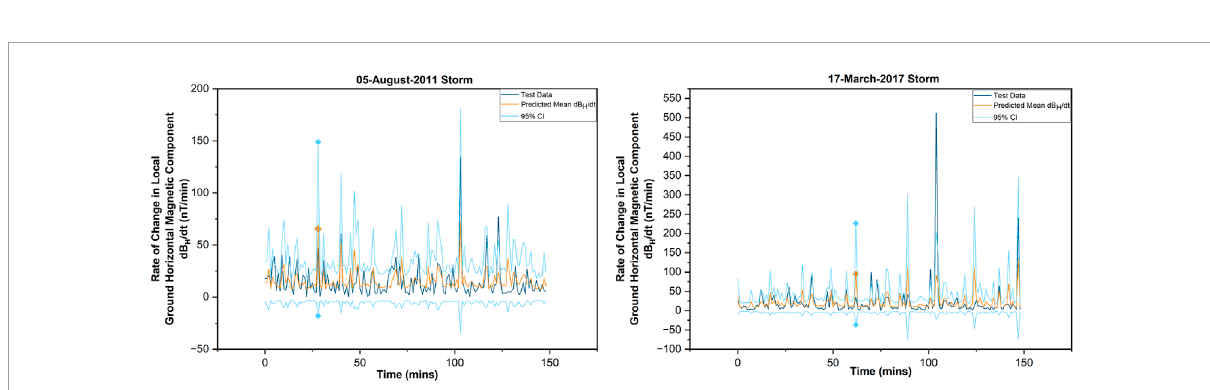
FIGURE 3 The predicted mean rate of local horizontal magnetic component ( dB H / dt ) , with corresponding variance at each time step, for the 05 August 2011 and 17 March 2015 storms. In each graph, an arbitrary predicted mean has been highlighted along with its corresponding upper and lower bounds, to exhibit the level of prediction uncertainty at that particular time step. The first 150 min have been shown in this figure for better visual details and exhibition of the prediction uncertainty. The graphs containing the predicted mean and observed dB H / dt over a time period of 24 h is included in the supplementary